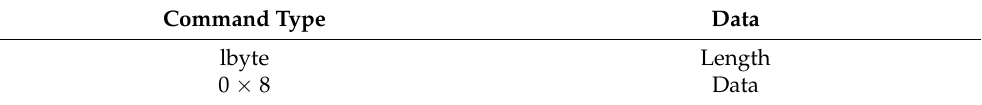
Table 5. Channel data packet.